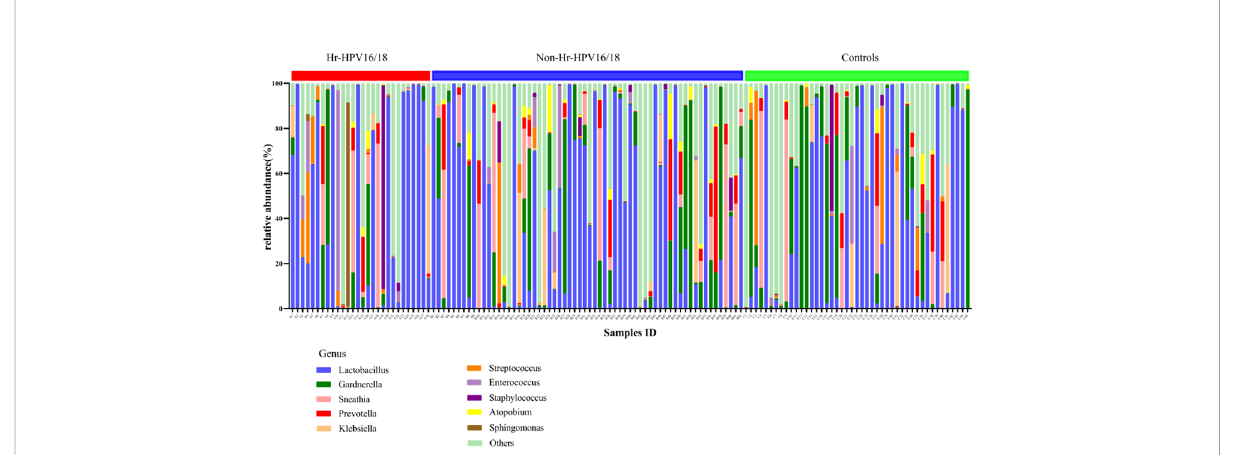
FIGURE 4 Vaginal fl ora at the genus level in infected and healthy